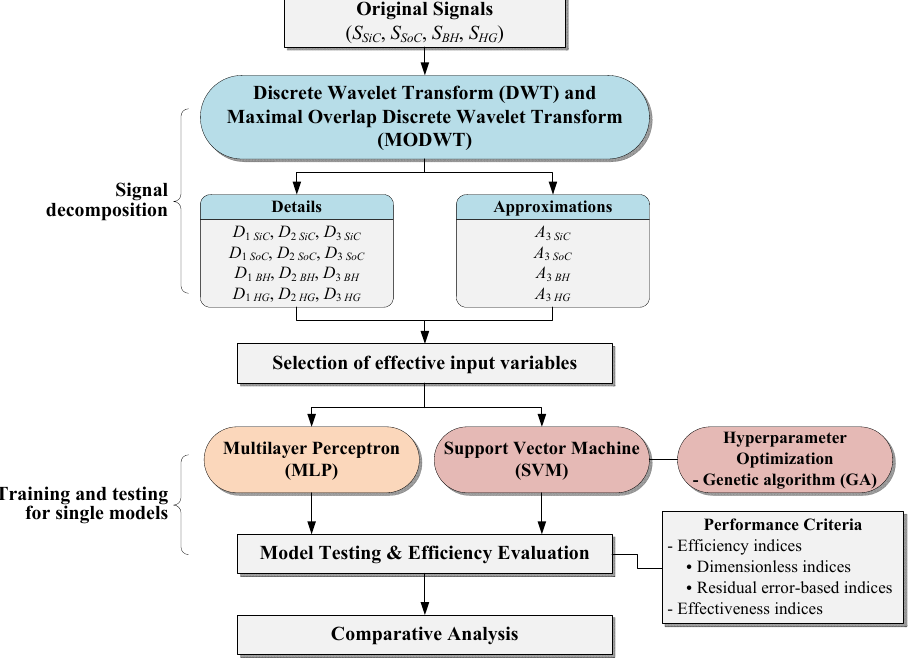
Figure 6. Flowchart of river stage modeling using DWT and MODWT.